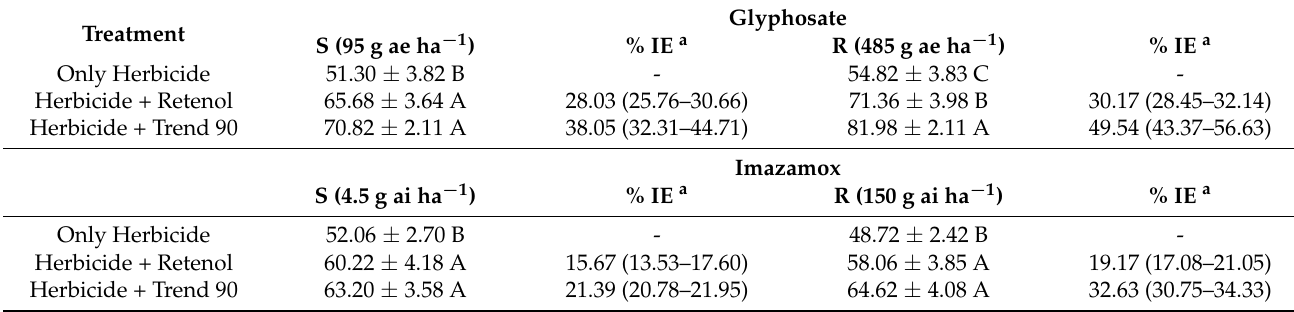
Table 4. Dry weight reduction (%) and increased effectiveness (%) with glyphosate and imazamox in the presence and absence of adjuvants from the R and S populations of Chloris radiata.